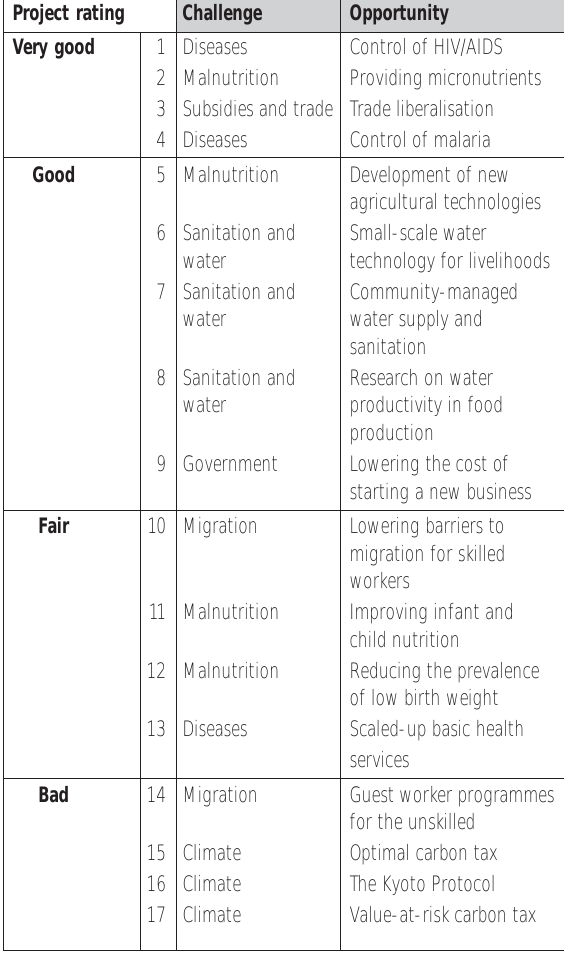
Fig. 1. Outcome of ranking exercise during the Copenhagen Consensus 2004 (for more information see